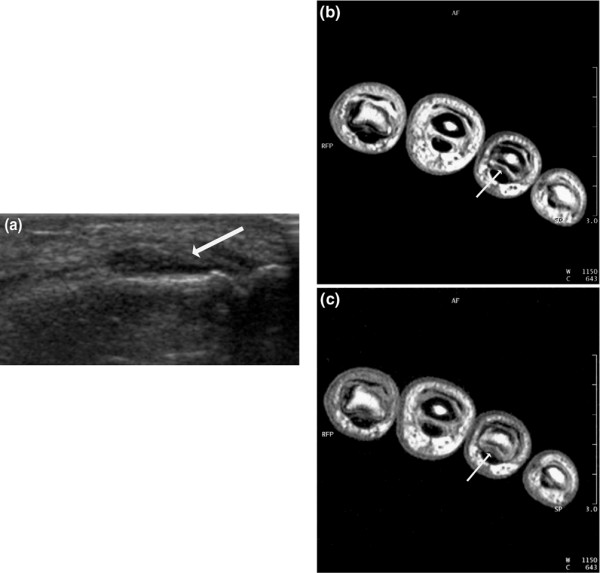
Signs of synovitis on ultrasonography and MRI in fourth proximal interphalangeal joint: early RA. Arrows indicate an area with synovitis. Ultrasonography in (a) the longitudinal plane from the dorsal aspect shows signs of synovitis (grade 4). Axial T1-weighted magnetic resonance images were obtained (b) before and (c) after contrast administration (grade 3 synovitis). MRI, magnetic resonance imaging; RA, rheumatoid arthritis.